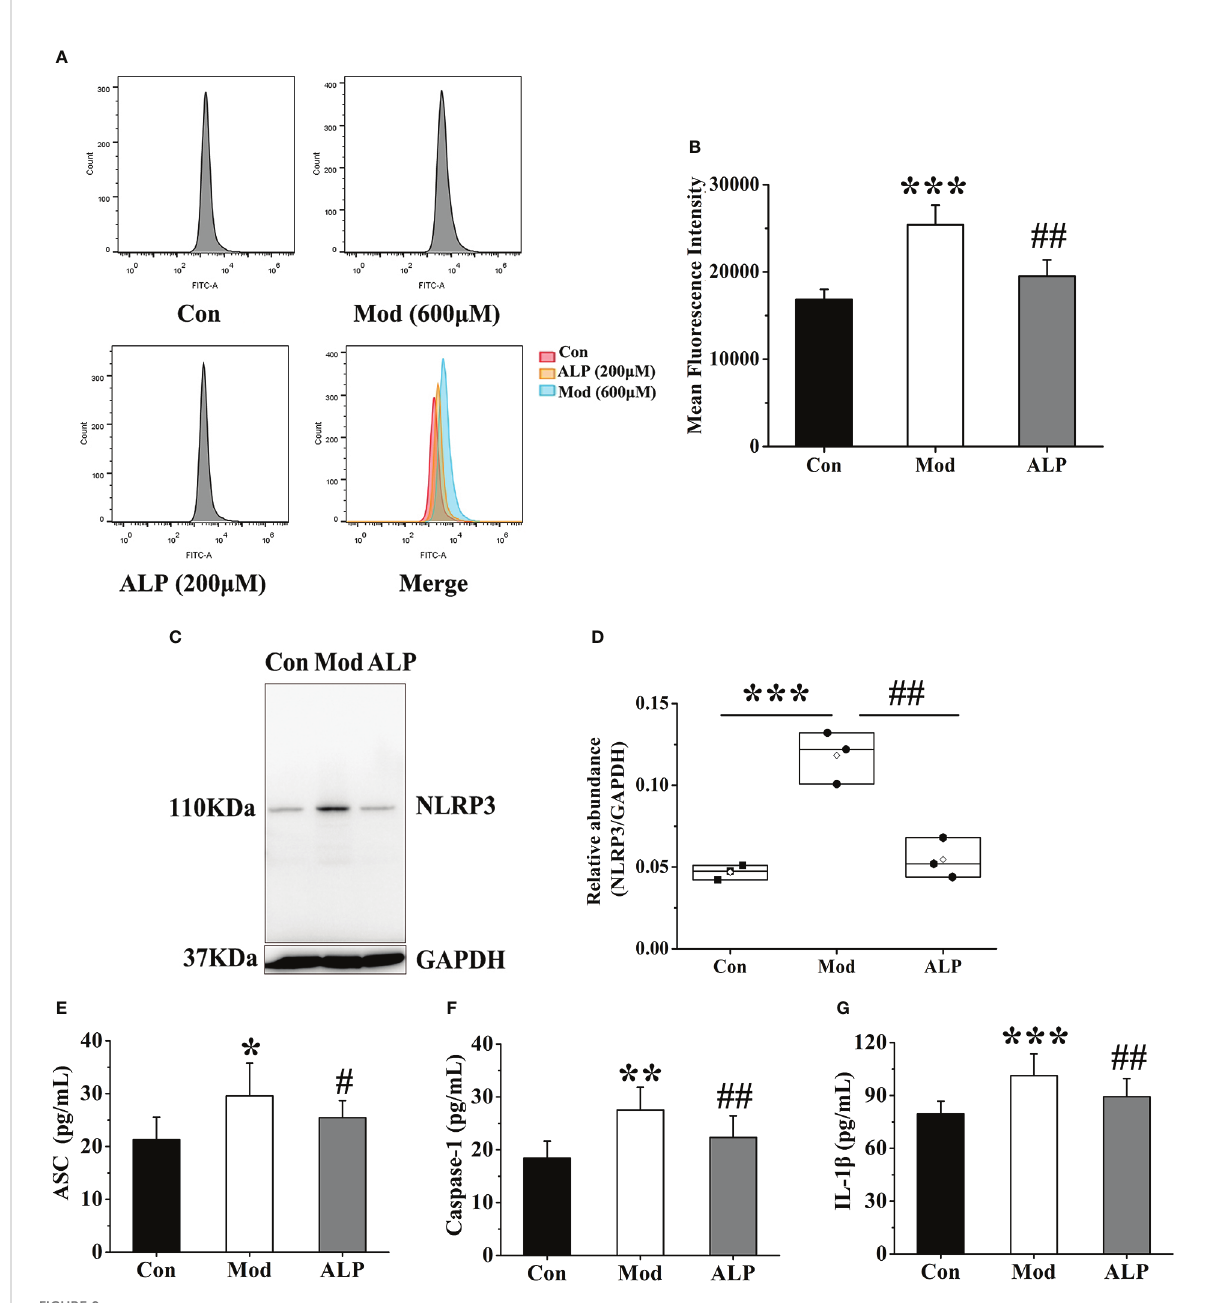
FIGURE 9 Allopurinol inhibits ROS and NLRP3 in fl ammasome in FLS after uric acid stimulation. (A) Detection of ROS expression levels in FLS by fl ow cytometry. (B) The mean fl uorescence intensity of FLS in each group. (C) Western blot was conducted to evaluate the protein level of NLRP3 and GAPDH in cell lysates. (D) Box plot showing the densitometry analysis of NLRP3 normalized by GAPDH. (E) The expression level of ASC in cell supernatant. (F) The expression level of Caspase-1 in cell supernatant. (G) The expression level of IL-1 b in cell supernatant. * P < 0.05, ** P < 0.01 and *** P < 0.001 versus Con group. # P < 0.05 and ## P < 0.01 versus Mod